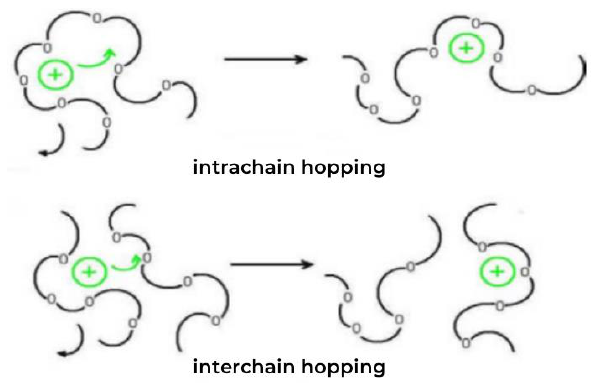
Figure 1. Schematic of Li + migration.